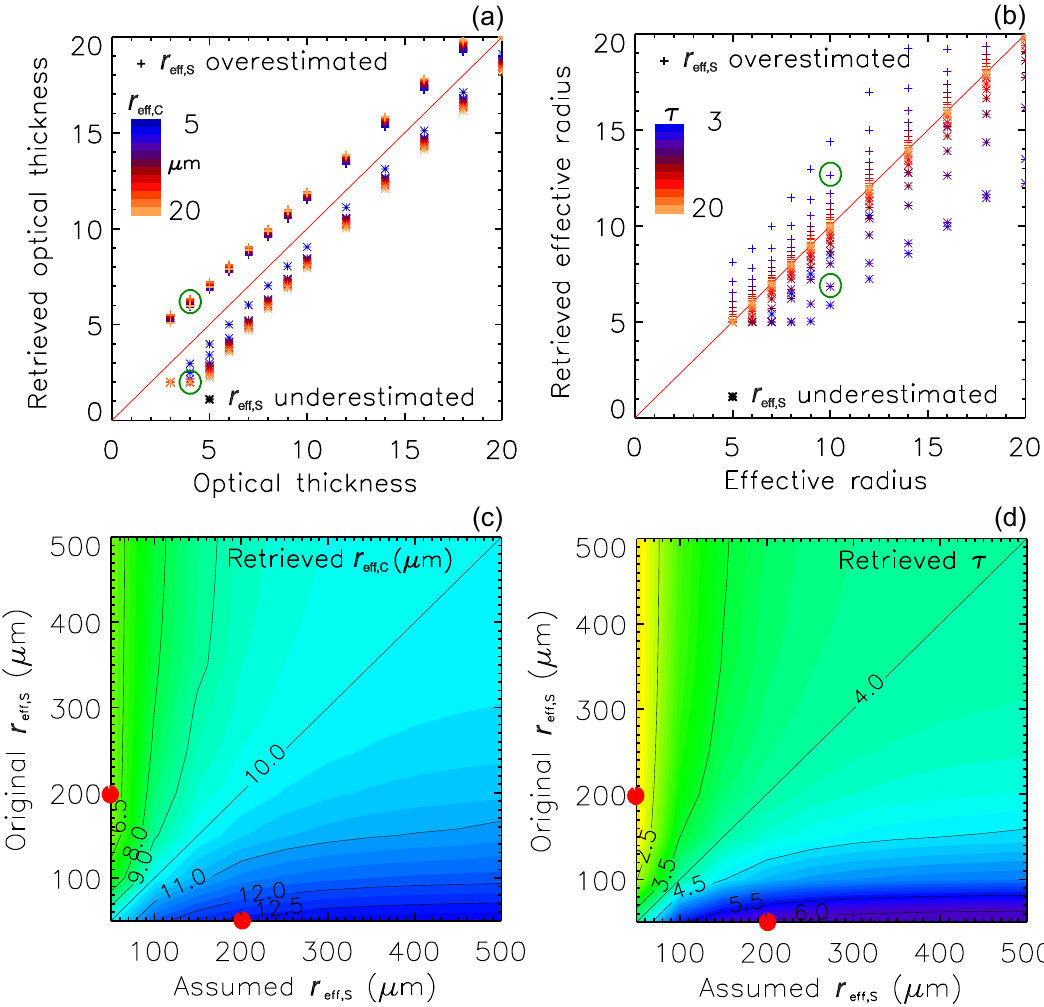
Figure 3. Comparison of synthetically retrieved τ (a, c) and r eff , C (b, d) with the original parameter value. Calculations in (a) and (b) are performed, assuming a larger effective snow grain size of r eff , S = 200µm instead of the original r eff , S = 50µm (crosses) and a smaller effective snow grain size of r eff , S = 50µm instead of the original r eff , S = 200µm (asterisks). In (c) and (d) all combinations of assumed and original r eff , S are analysed for a specific cloud of τ = 4 and r eff , C = 10µm. The red dots in (c) and (d) indicate the cases included in (a) and (b) , where results for the same cloud are indicated by green